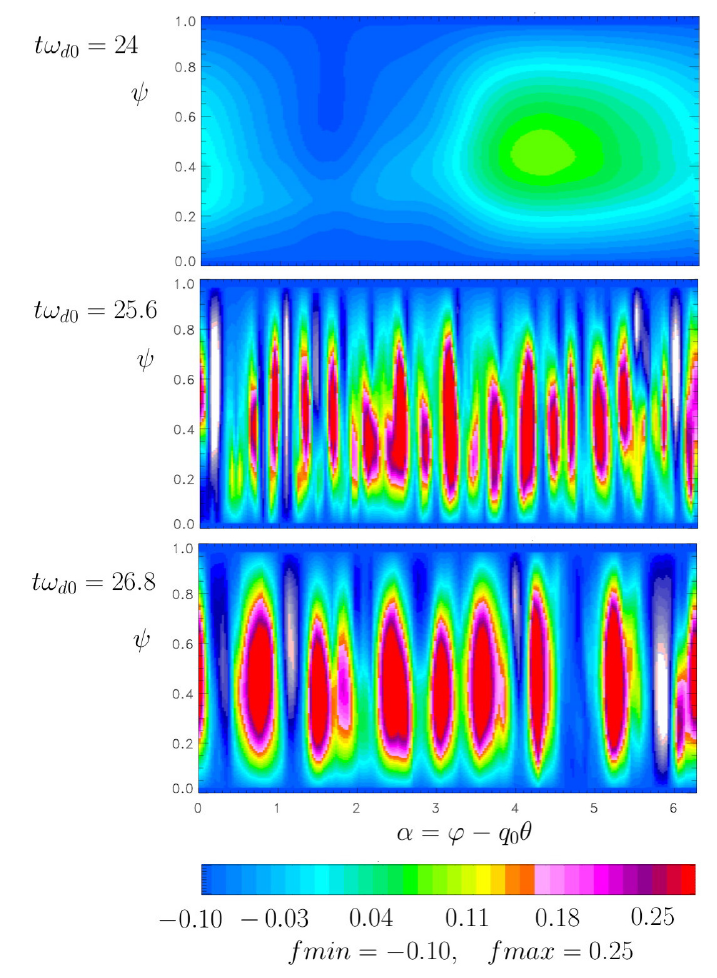
Figure 9. Diagrams show that streamers are also occurring but on a higher mode (with a toroidal number of n = 20 ) , as can be seen on the plot shown at time t ω d 0 = 25.6. Here, the polarization factor is C i = 1.25.